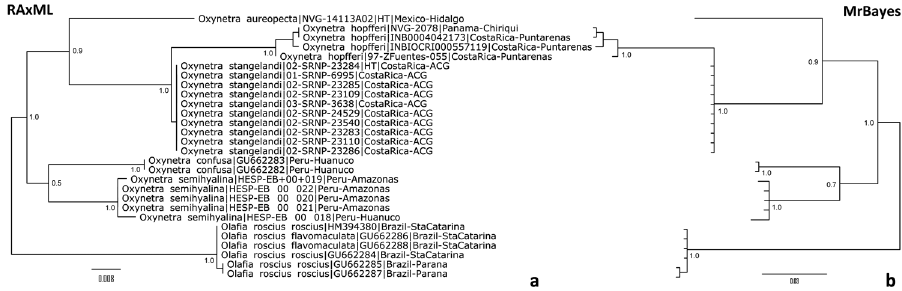
Figure 11. COI DNA barcode trees of Oxynetra species. The trees are obtained by a RAxML under “GTRGAMMA” model; and b MrBayes under “propinv” model with 2 states (see Materials and Meth- ods) and show identical topology. The taxa are arranged in the same sequence in both trees. The trees are rooted with Olafia Nemésio, 2005 sequences. Bootstrap fractions (a) and posterior probabilities (b) are shown (except for nodes within species). Sequences with NVG- voucher codes were obtained in this work. For other sequences, ACG voucher codes (with -SRNP- and -ZFuentes-, Janzen & Hallwachs 2014), INBio voucher codes (starting with INB, Grishin et al. 2013), GenBank accessions (starting from GU and HM, http://genbank.gov/), or Ernst Brockmann collection voucher codes (with HESP-EB) are indicated for each sequence. The general locality of each specimen is